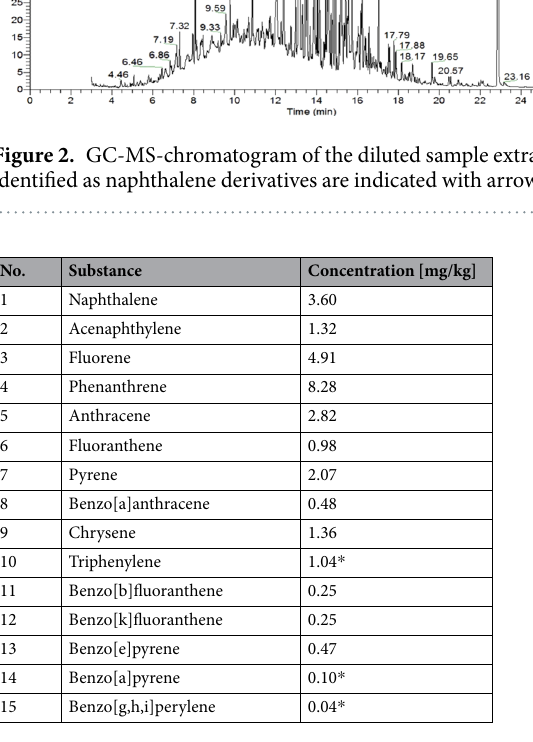
Table 2. Identified PAHs in the sample. Concentrations marked with a * did not lie within the calibration range and were therefore only